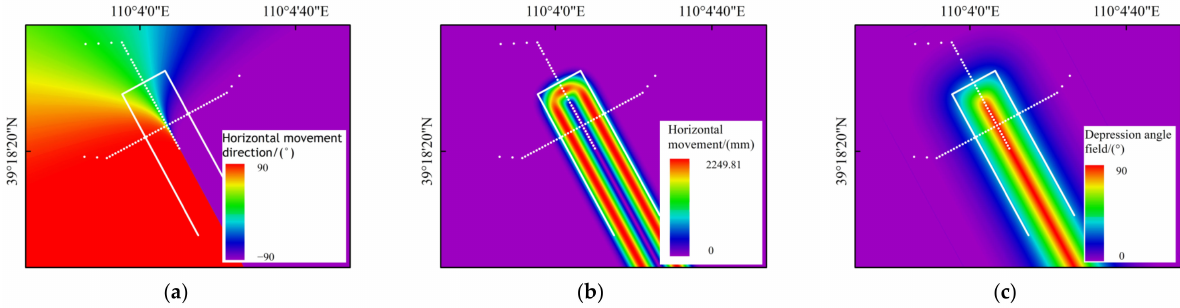
Figure 13. Some deformation field components: ( a ) horizontal movement direction field, ( b ) horizontal movement field, and ( c ) depression angle